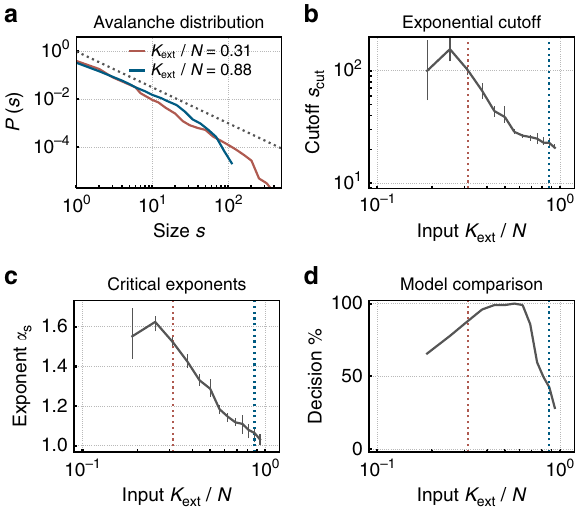
Fig. 2 Under low degree of input K ext , the network self-organizes toward a critical state, and shows long-tailed avalanche distributions. a Distributions of avalanche sizes Pð s Þ show power laws over two orders of magnitude for low K ext . Fitting a truncated power law, b the exponential cutoff s α s approximate 1.5, as expected for critical cut peaks, and c critical exponents branching processes. d A maximum-likelihood comparison decides for a power law compared with an exponential fi t in the majority of cases. Dashed vertical lines indicate the set of K ext / N values that have been selected in a . In this and all following fi gures, the median over runs and (if acquired) trials is shown, and the errorbars show the 5 – 95% con fi dence intervals.